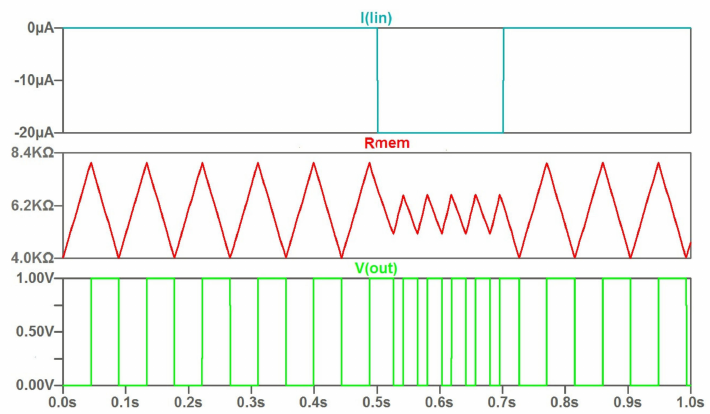
Figure 2. The time diagram for control by current pulse: input current pulse; character of the sawtooth change of memristor resistance R under current control; waveforms of voltage changes at the output of the oscillator circuit V(out) .